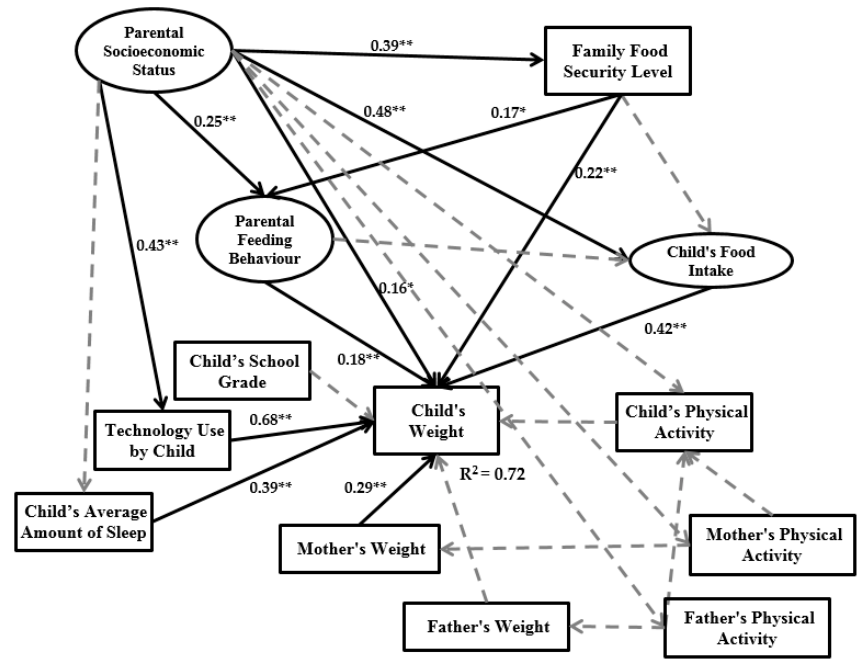
Figure 6. Obesity model output (* Significant in the level of 5%; ** Significant in the level of 1%).